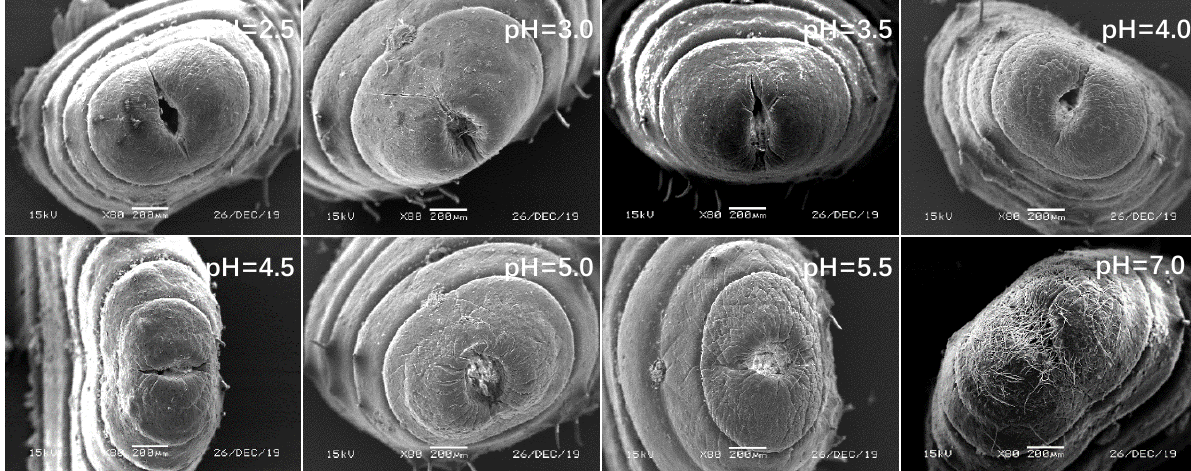
Figure 11. Anus of adult Eisenia fetida in soil under acid rain with eight pH levels for 15 days ( n = 10). Treatments: pH 7.0: control, pH 2.0–5.5: acid rain with different pH levels.